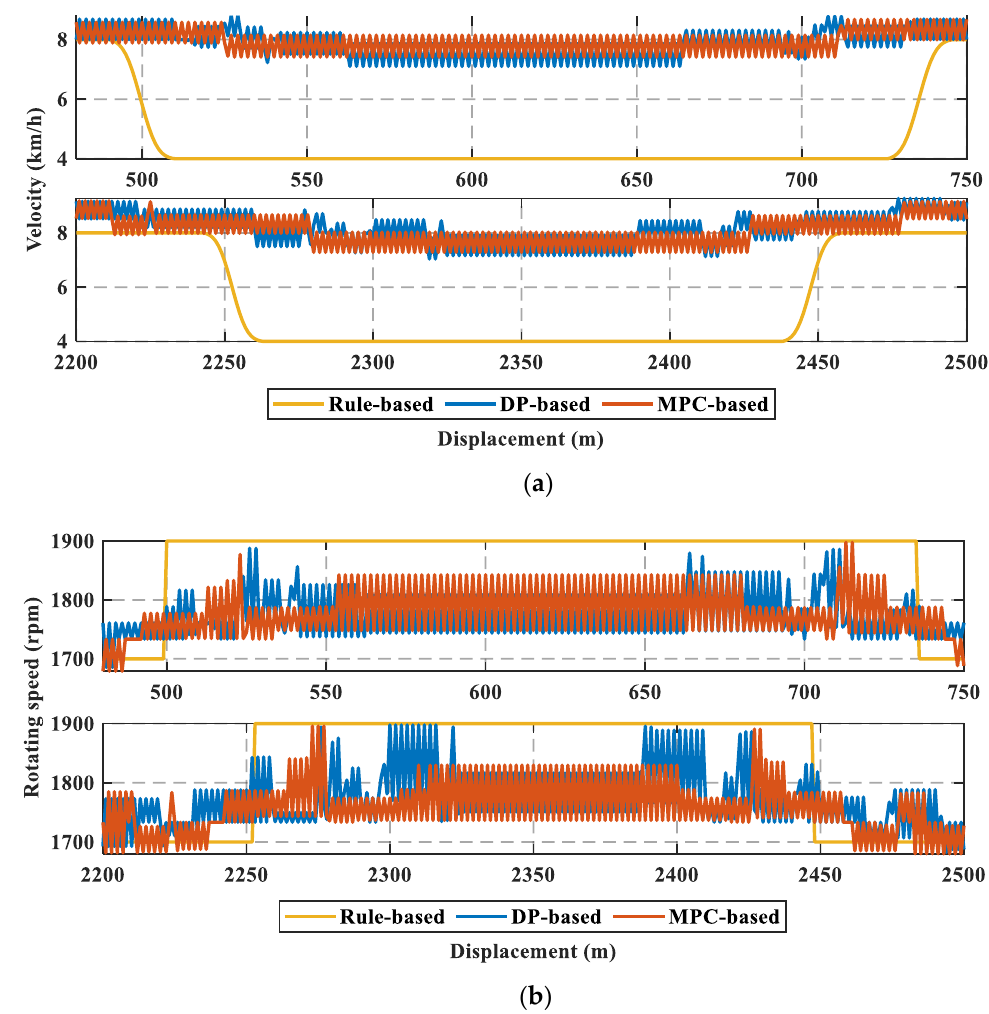
Figure 29. Magnified control variables: ( a ) vehicle velocity and ( b ) rotating speed of the working motor.